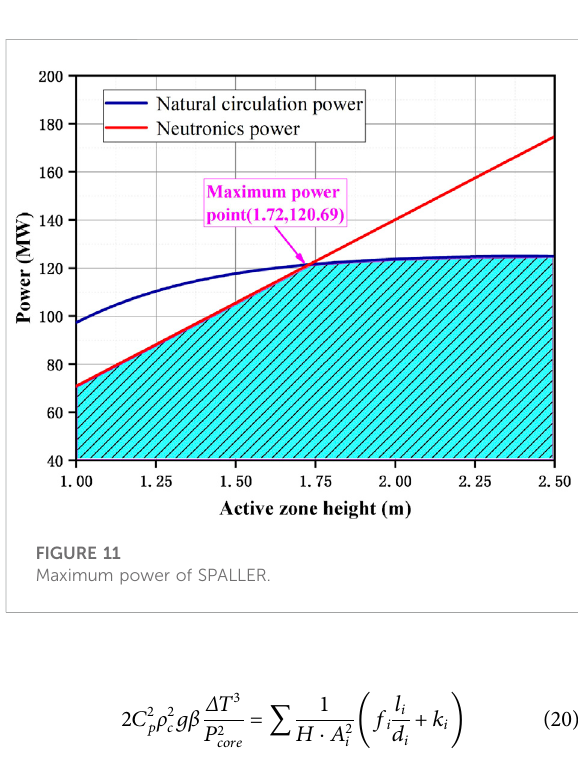
FIGURE 11 Maximum power of